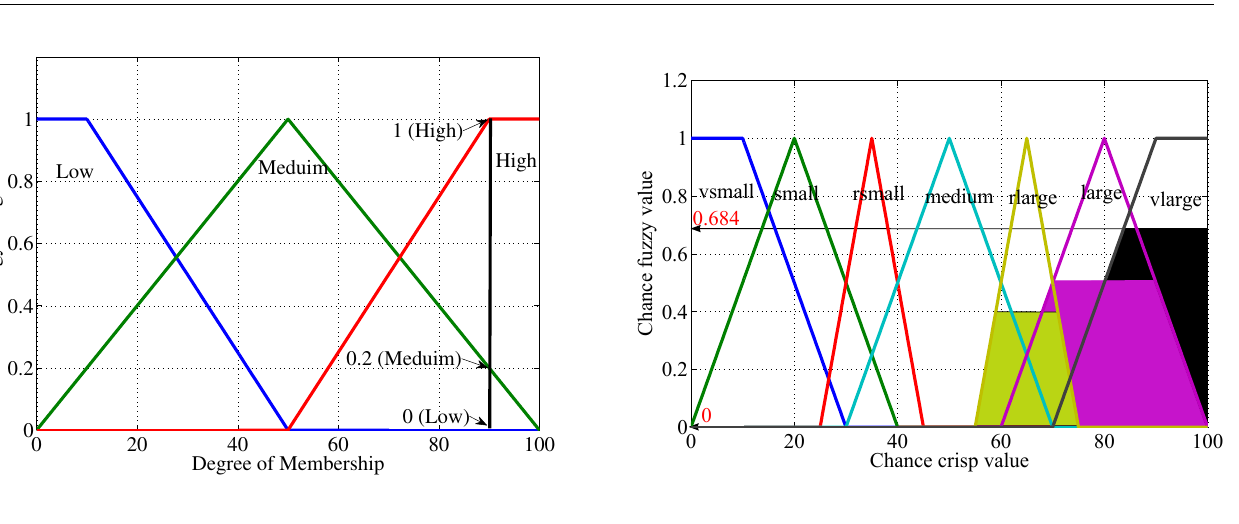
Figure 8. Rules aggregation